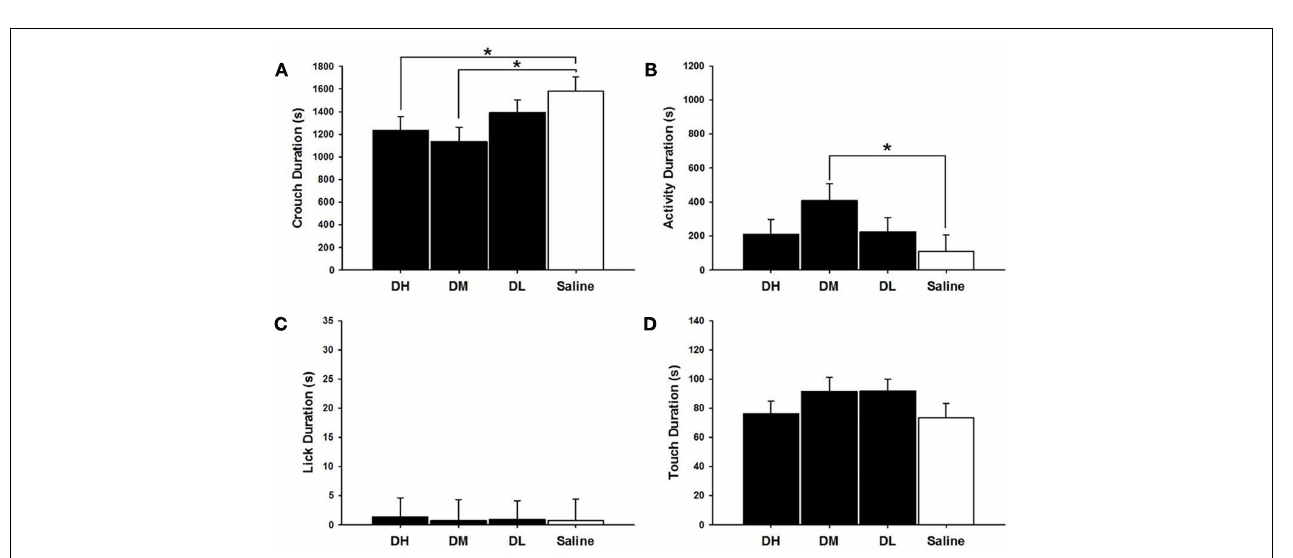
groups and saline controls. Gray bars denote amytriptyline groups [AH, amitriptyline high (10mg/kg); AM, amitriptyline medium (5mg/kg); AL, amitriptyline low (2.5mg/kg)].While bars denote saline control group [Saline = normal saline (2ml/kg)]. * p ≤ 0.05; ** p ≤ 0.01.